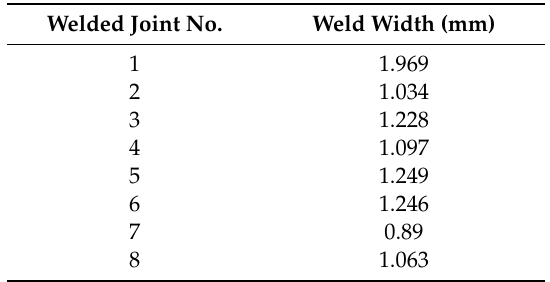
Table 6. Measured width for dissimilar metal-welded joints. Welded Joint